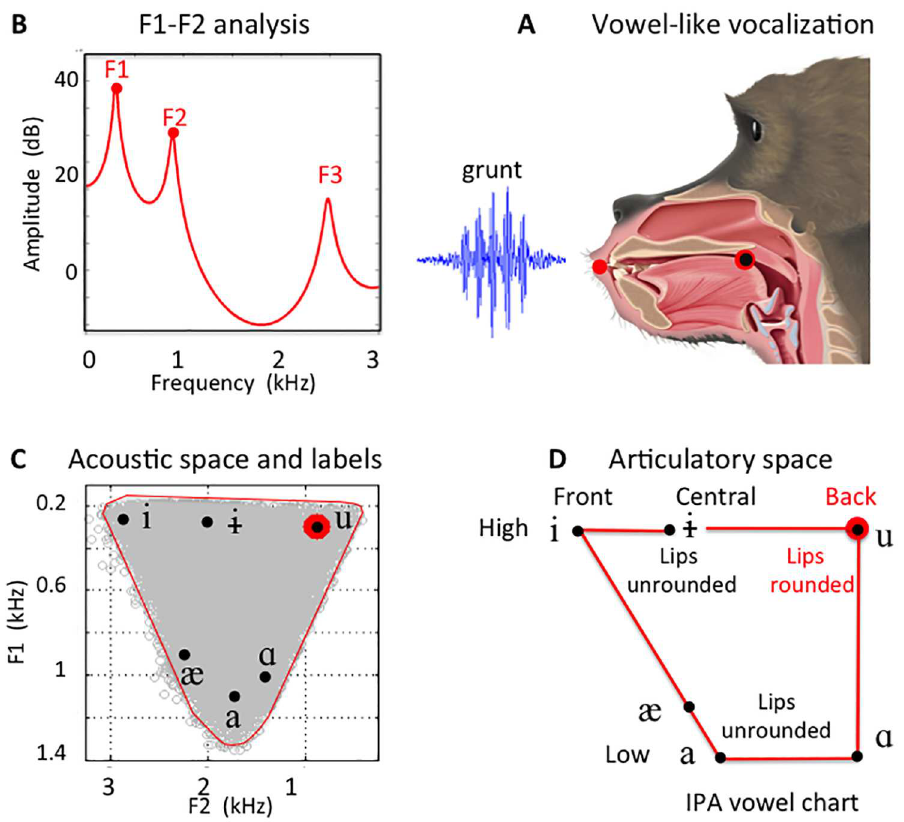
Fig 1. Procedure for acoustic analysis and VLS labeling. (A) Vocalizations in both human and nonhuman primates use the acoustic signal from the vocal folds vibrating at their fundamental frequency (F0). The formant frequenciesdependon the configuration of the vocal tract and the lip opening.(B) LPC analysiswas used to reveal the formants of each VLS (supplemental informationS2 Fig) [28,29].(C) A Monte Carlo procedure using an n-tube model normalizedfor the anatomical measuresof the baboons’ vocal tracts then served to generatethe MAS (shown by the red line). With this normalized MAS reference, any VLSs could be preciselylabeledwith the IPA vowel symbols [30,31].(D) The VLSs thus labeledcorrespondto well- documentedarticulatory configurations with characteristic tonguepositions and lip openings. (A-D) Red- &-black dots indicatethe corresponding values for this illustrative grunt vocalization, which is classifiedas